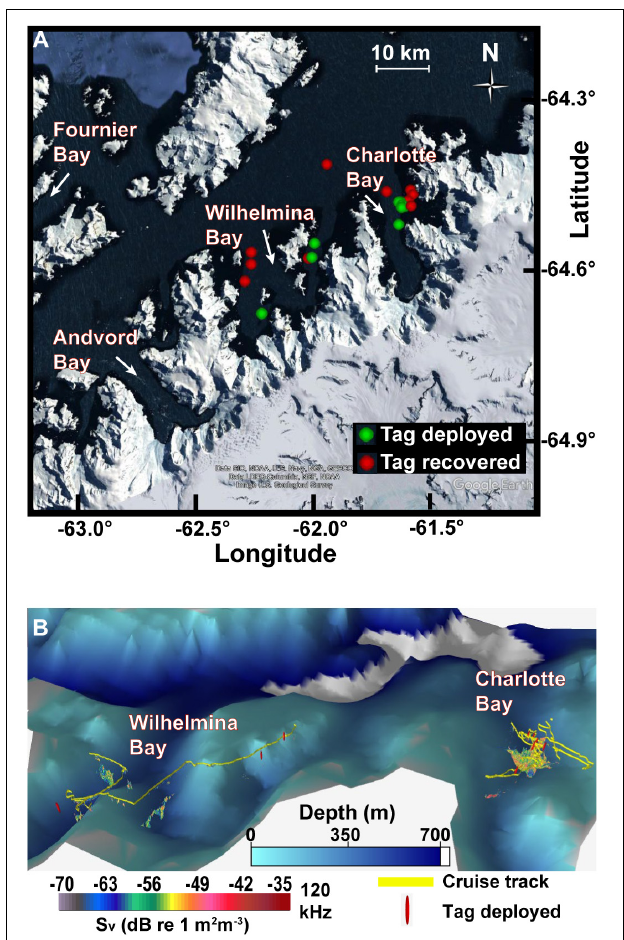
FIGURE 1 | Study area. (A) Tag deployment and recovery locations in the two fjords along the West Antarctic Peninsula. (B) Oblique view of study area with survey track, tag deployment locations, and acoustically detected patches. Data plotted in Echoview v11 with 8 × vertical exaggeration. Bathymetric data at 1 arcmin resolution (Globe Task Team et al., 1999). Resolution of bathymetric data means some acoustic data in this view is not